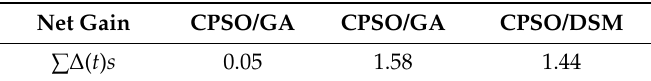
Figure 5. Convergence characteristic graph for Case I. Table 4. Comparison of the total net gain in time achieved by the proposed algorithm with the literature for Case